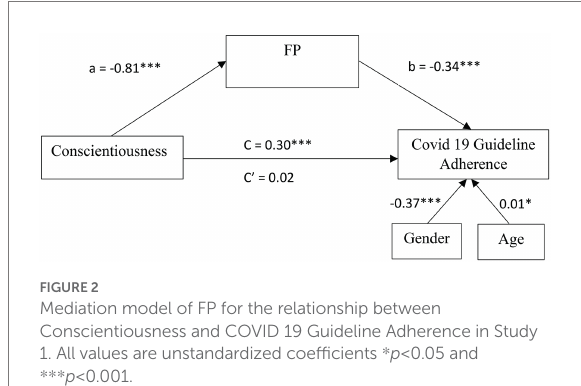
FIGURE 2 Mediation model of FP for the relationship between Conscientiousness and COVID 19 Guideline Adherence in Study 1. All values are unstandardized coefficients * p < 0.05 and *** p <